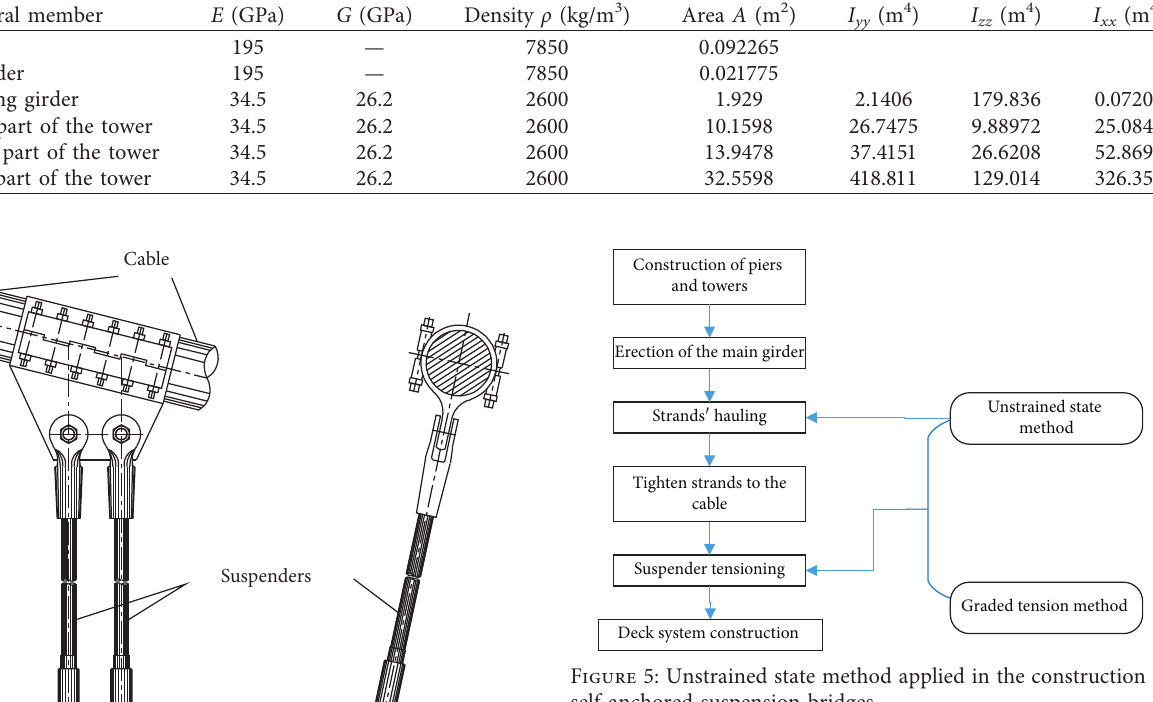
Table 1: Material and cross-sectional properties of bridge A.